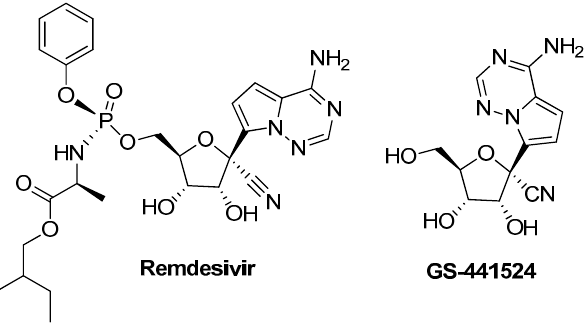
Figure 3. Molecular structure of remdesivir and GS-441524.